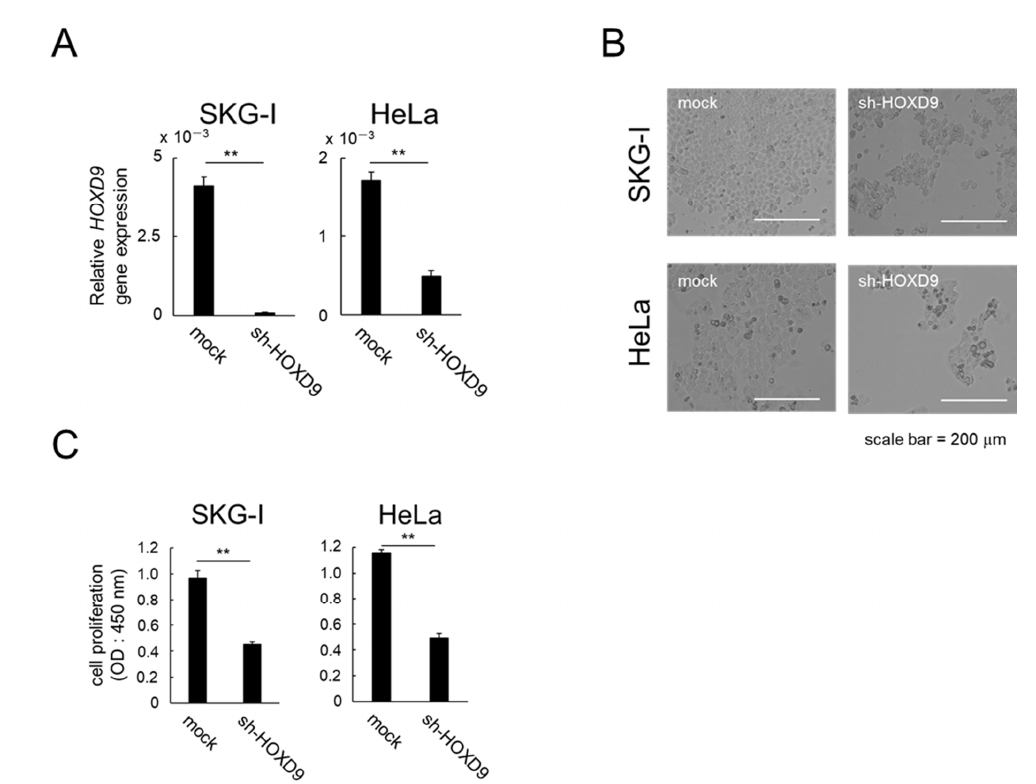
Figure 1. HOXD9 regulates cell proliferation in CC cell lines. SKG-I and HeLa cells were transfected with Scheme 9. (sh-HOXD9) or shRNA-empty vector (mock). ( A ) Total RNA was extracted and HOXD9 mRNA was evaluated by real-time RT-PCR at 48 h post-transfection. (means ± SD; n = 3)( B , C ) Proliferation of SKG-I and HeLa cells measured by microscopic observation ( B ) and WST-1 assay ( C ) (means ± SD; n = 3). ** p < 0.01.